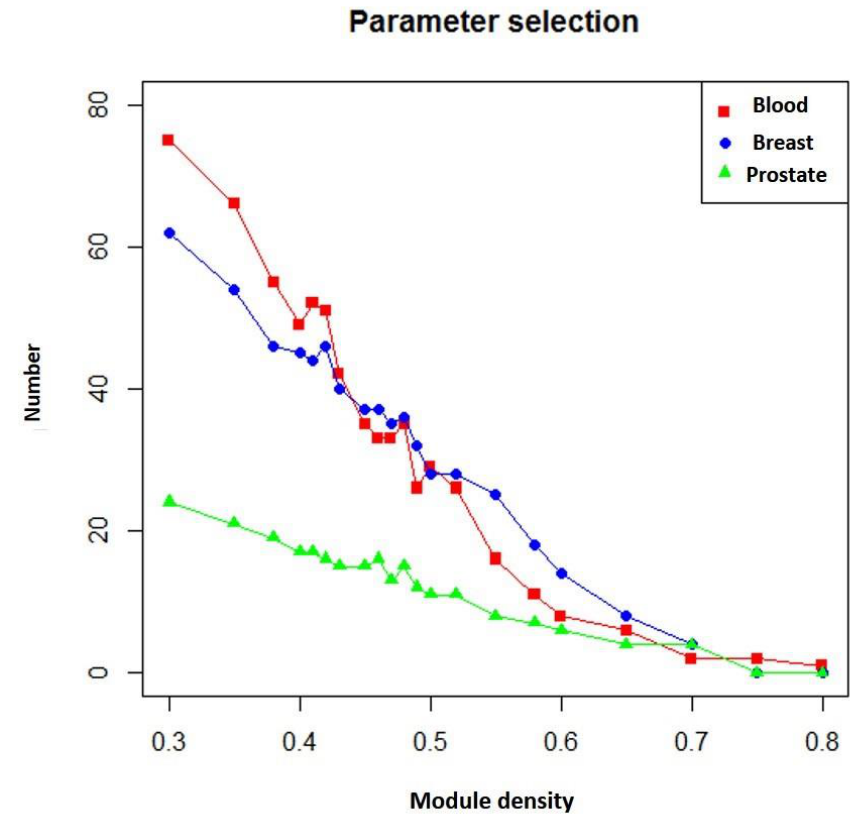
Figure 5. Numbers of overlapping genes between modules generated under di ff erent heaviness values and genes a ff ected by TSA in di ff erent diseases. Red line: blood (leukemia); blue line: breast (breast cancer); green line: prostate (prostate cancer). The X axis represents heaviness values (“module density), and the Y axis indicates the number of overlapping genes